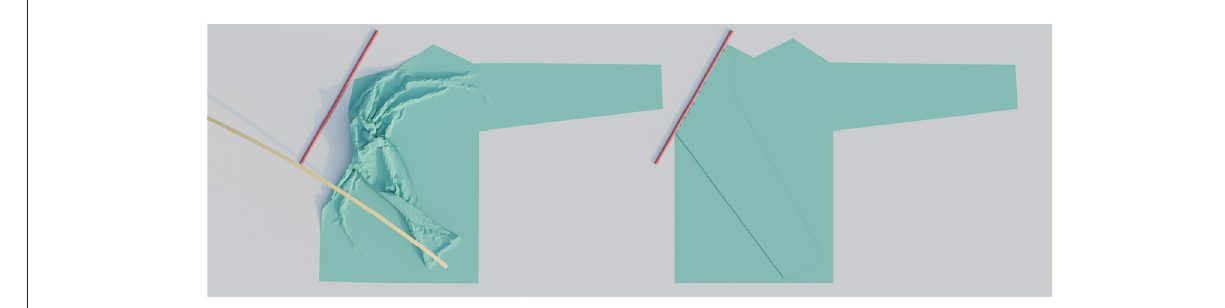
FIGURE5 On the left is an example of a simulated result and on the right the idealized target shape. The image on the left has a loss of 2.1 cm, which means the vertices are on average 2.1 cm removed from their desired location.